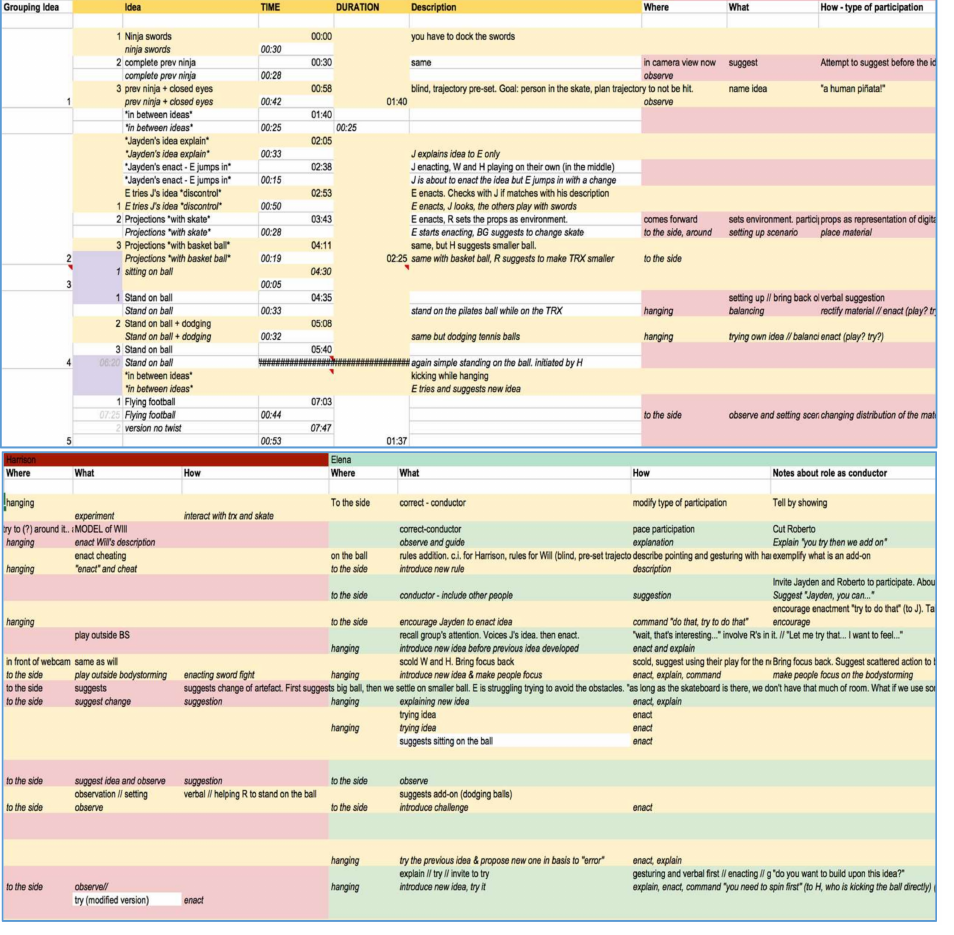
Figure 2. Screenshot of the codes of the datasheet for the HangXRT case. The different columns and rows can be observed. They have also been color-coded to enhance the